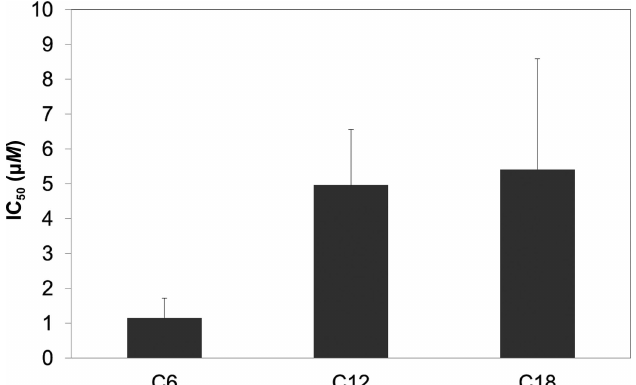
Figure 5 Fatty-acid binding measured by the displacement of a fluorescent probe (1,8-ANS) bound to human EPDR1. Fatty-acid binding to human EPDR1 was inferred by measuring the three fatty-acid (C6, caproic acid; C12, lauric acid; C18, stearic acid) concentrations necessary to replace 50% of 1,8-ANS (IC 50 ). Note that the C6 and C12 displacement studies were performed in 0.5% ethanol buffer and that the C18 displacement study was performed in 2% ethanol buffer owing to the limited solubility of C18 in